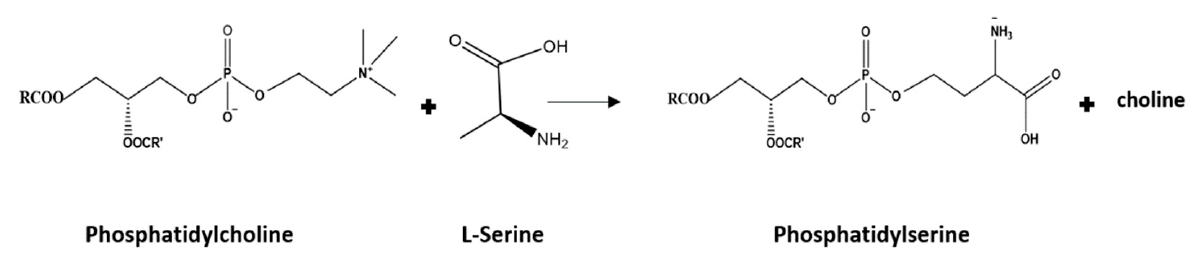
Figure 1. Reaction scheme of transphosphatidylation to PS from PC. Table 1. Percentage of different phospholipids found in common plant and animal sources (Table modified from Szuhaj